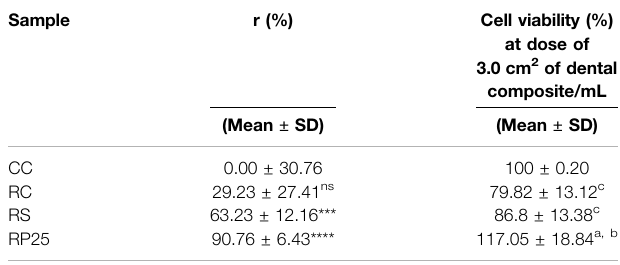
TABLE 5 | Antibacterial ratio and cytotoxicity of Brazilian red propolis enriched dental composite.